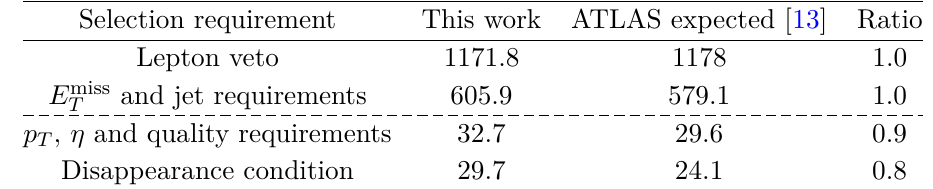
Table 2 . Cut flow for the ATLAS EW triplet benchmark point, ( m for simulated events with an integrated luminosity of 36 . 1 fb − 1 , and corresponding ATLAS expectation. Requirements below the dashed line are applied to truth charginos in our analysis, as explained in the